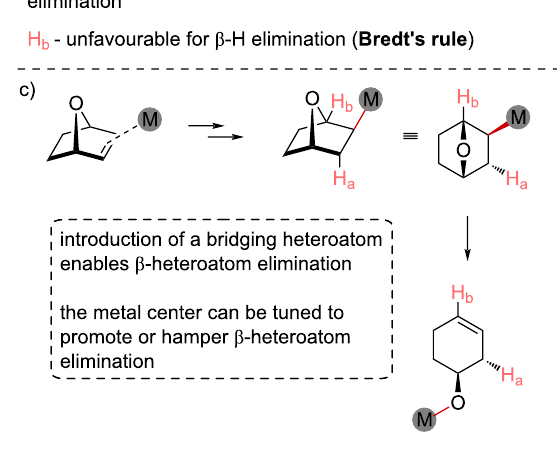
Figure 2: a) Exo and endo face descriptions of bicyclic alkenes. b) Reactivity comparisons for different β -atom elimination steps for an exo- metallated intermediate carbobicyclic system. c) Reactivity com- parisons for different β -atom elimination steps for an exo- metallated intermediate oxabicyclic